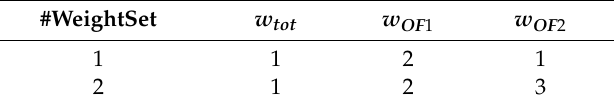
Table 2 . OF3 weights tested in the study. Table 2. OF3 weights tested in the study.